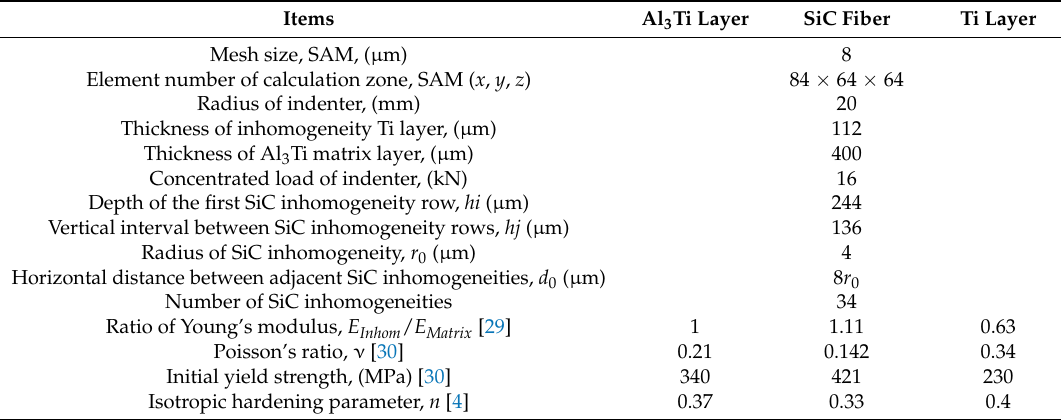
Figure 8. XOZ cross section of the three-dimensional (3D) SAM model for validation. Table 1. Parameters of the new NEIM-based SAM model for validation.